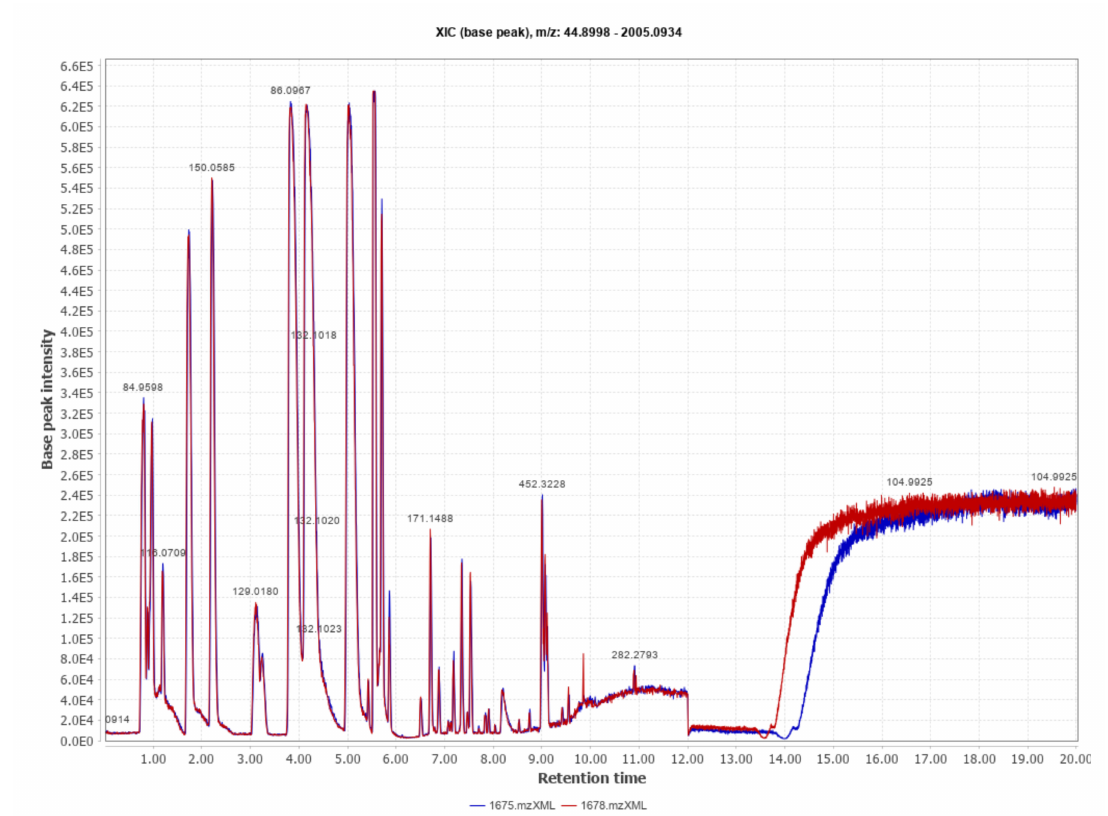
Figure 1. Metabolic spectral profile obtained by UHPLC-TOF MS-MS from two samples of embryo culture medium (CM) in positive-ion mode (range 100–1500 m/z ). The total ion count (TIC) chromatograms correspond to a CM sample from one embryo diagnosed as pregnant (blue) and one embryo diagnosed as non-pregnant (red) on